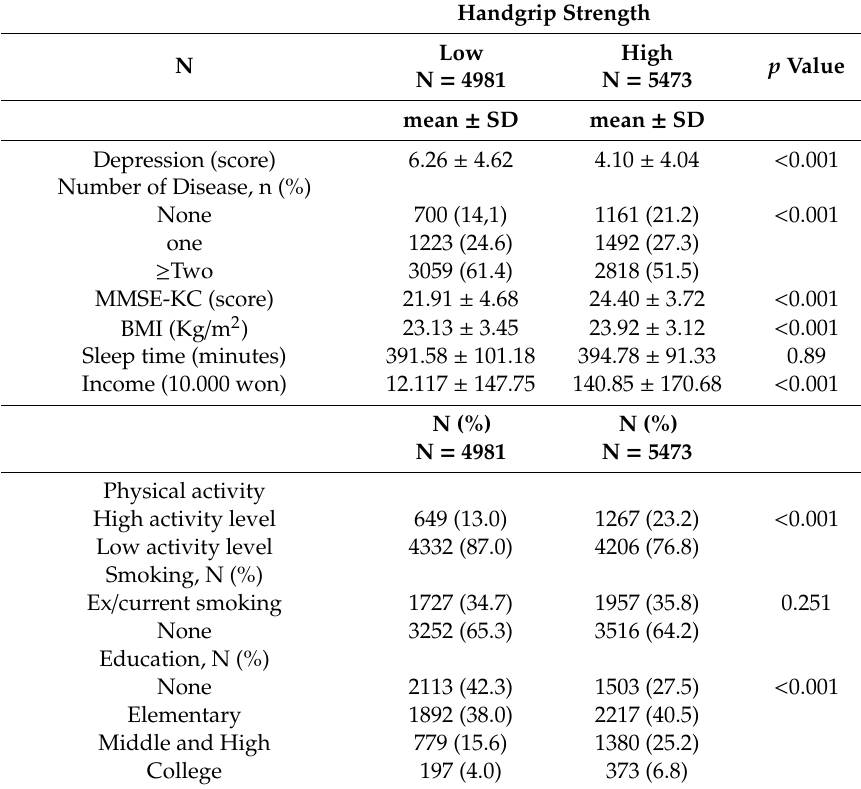
Table 3. Comparison of variables following handgrip